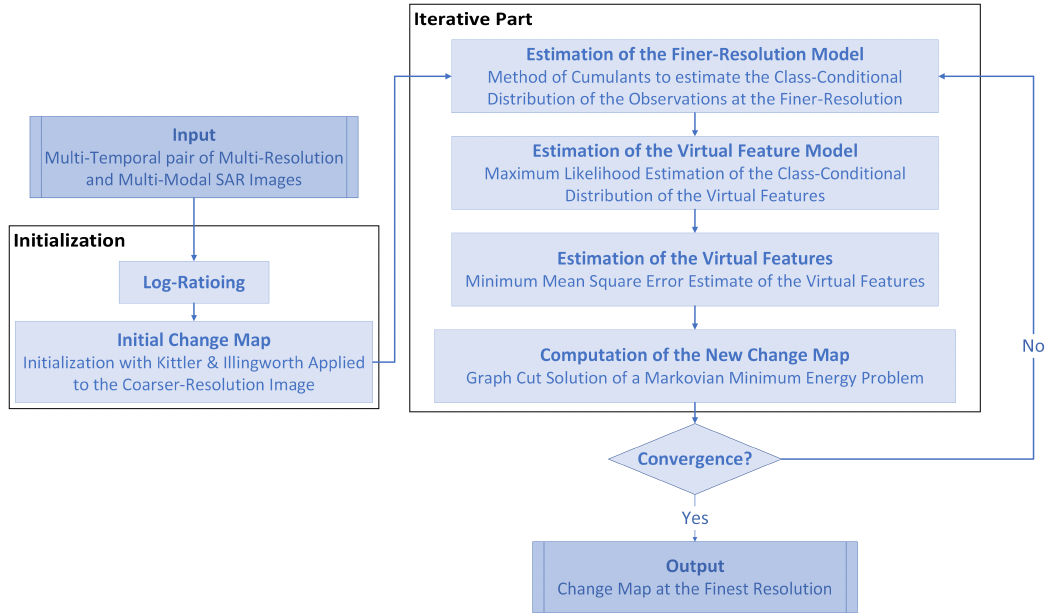
Figure 2. Flowchart of the proposed